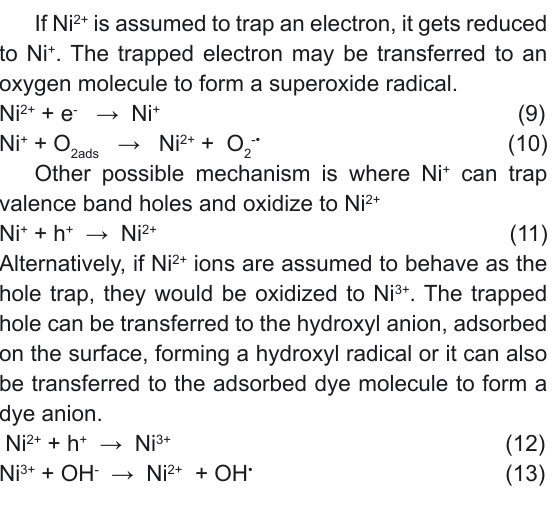
photocatalystsNi-3